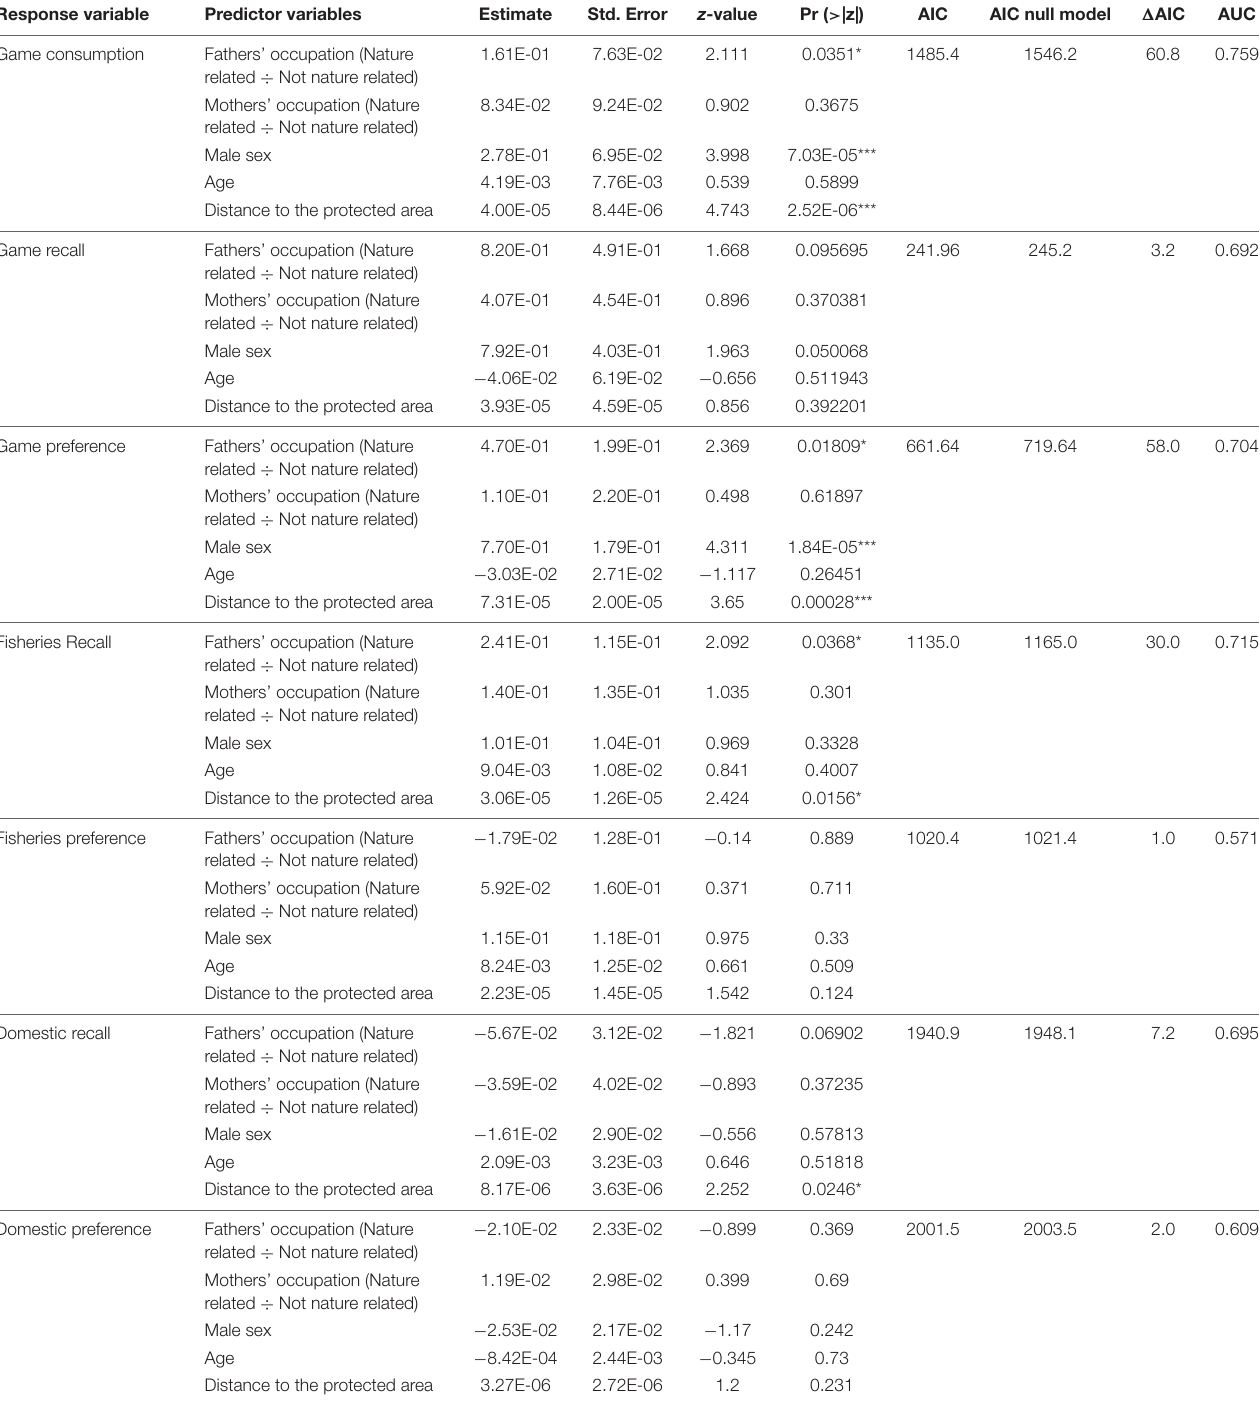
TABLE 1 | Estimates of generalized linear mixed models selected based on the Akaike Information Criterion (AIC) and the area under the curve (AUC) of the receiver operating characteristic (ROC). † Response